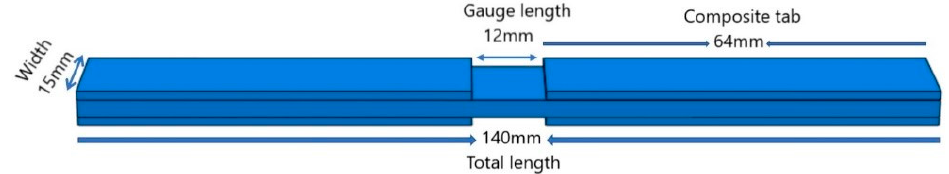
Figure 7. Schematic diagram of the edgewise compression test specimen.